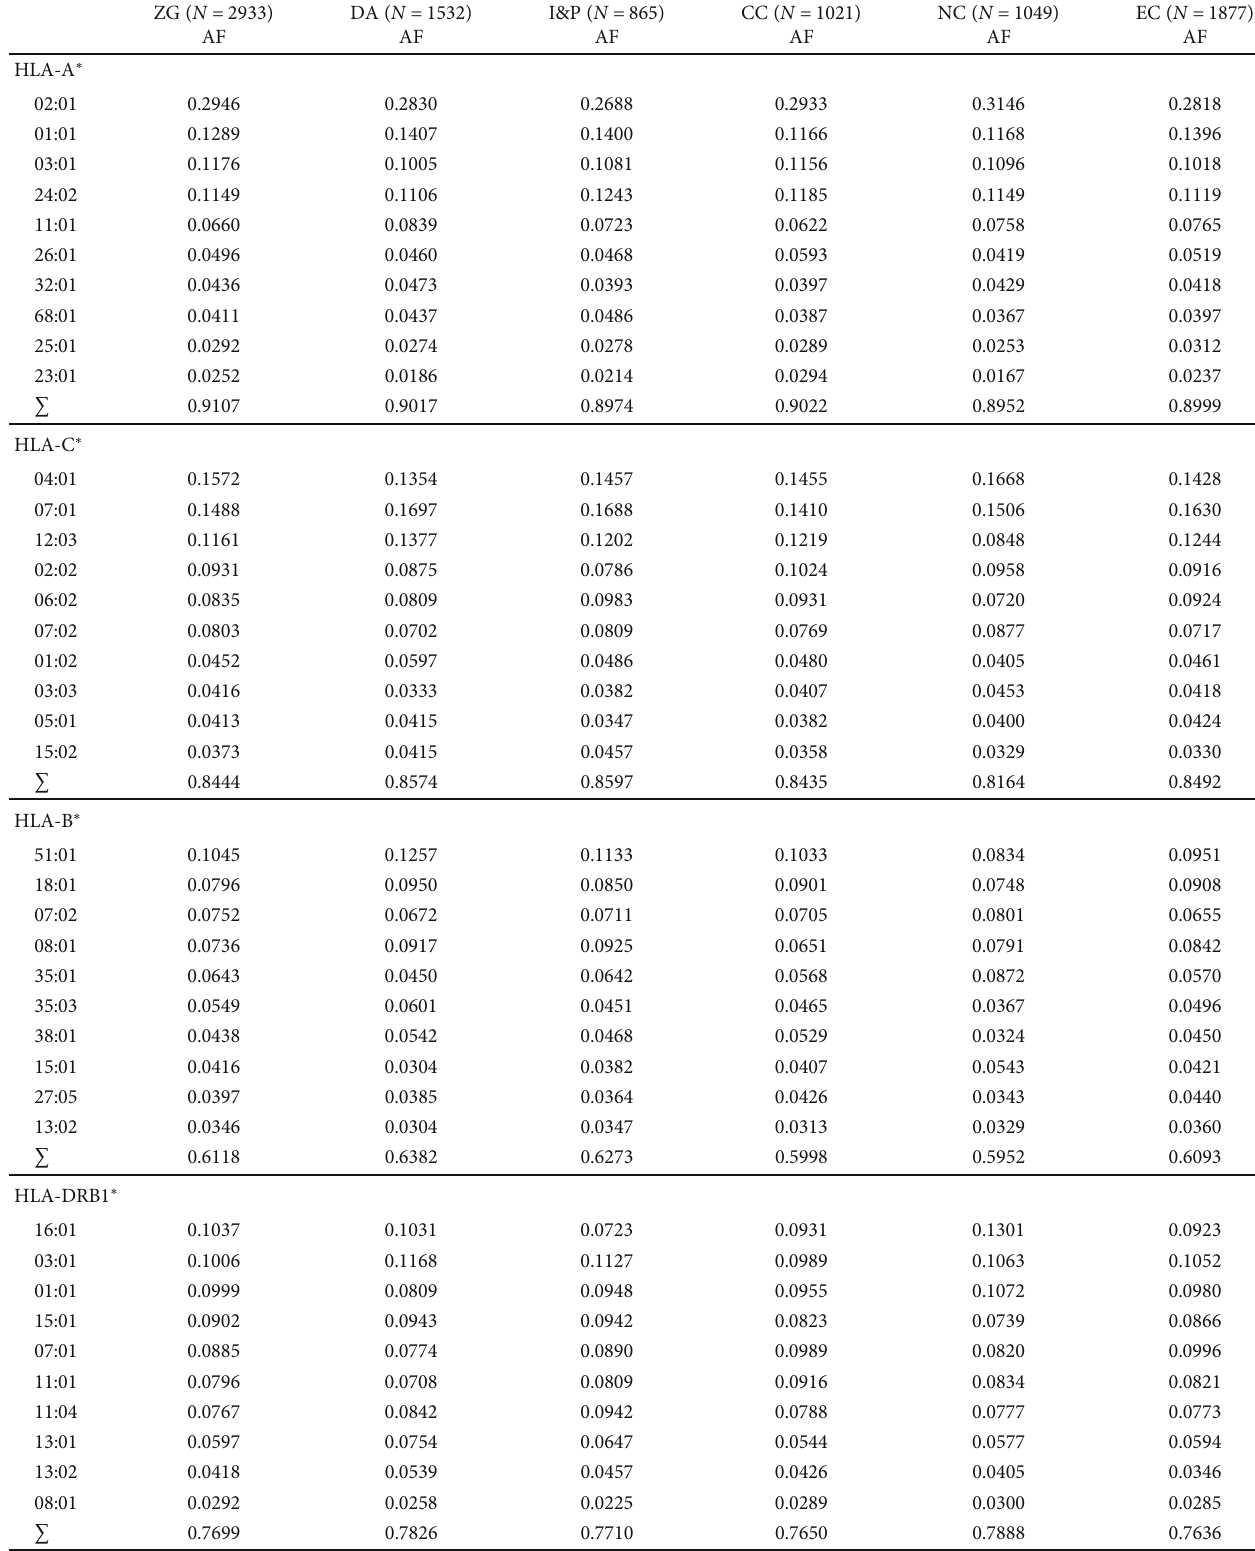
Table 2: The frequency of the 10 most frequent HLA-A, -C, -B, and -DRB1 alleles in Zagreb and their respective frequencies in fi ve di ff erent Croatian